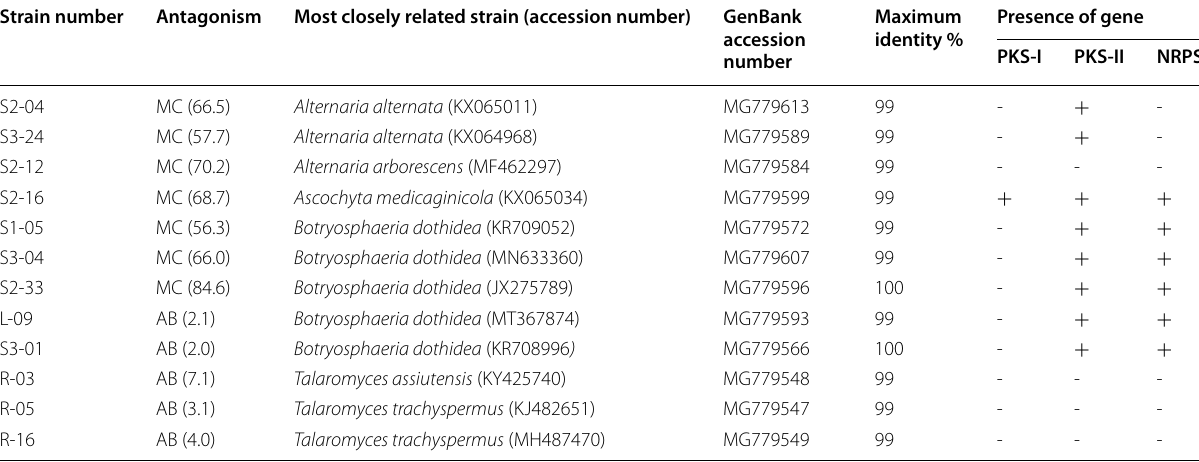
(1) The letters in the antagonism represent different antagonistic effect. MC and AB represent matrix competition and antibiosis respectively. (2) The numbers in parentheses after MC and AB represent “inhibition rate%” and “width of the inhibition zone (mm)” respectively. (3) The signs “ absence of the corresponding gene, respectively